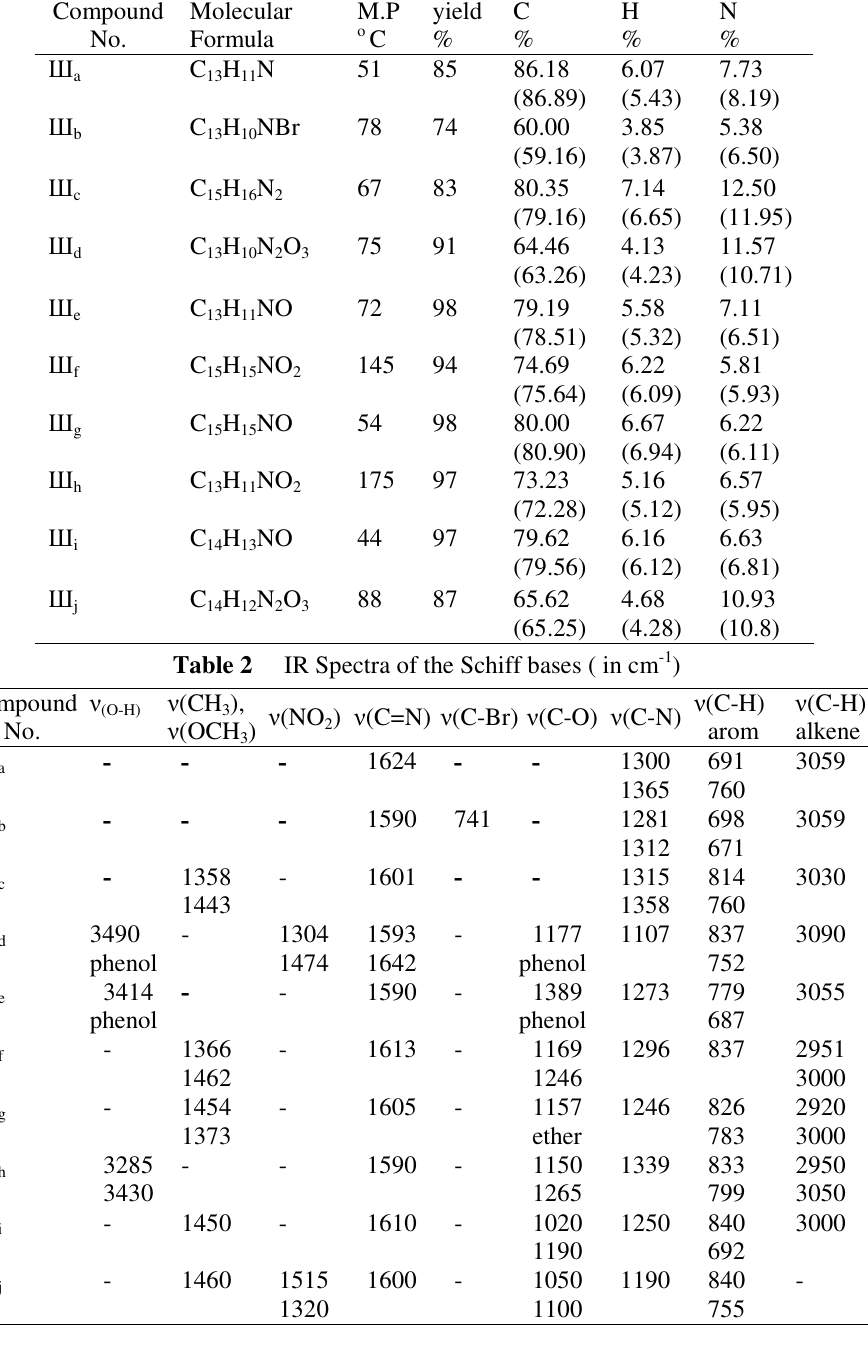
Physical Properties of Schiff bases and Elemental Analysis